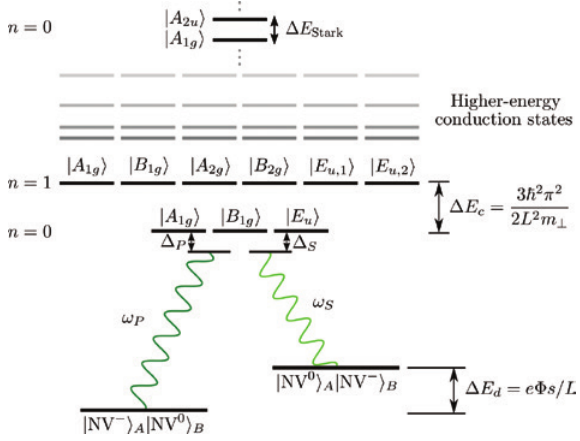
Figure 2: Nanowire energy-level diagram for the STIRAP transport